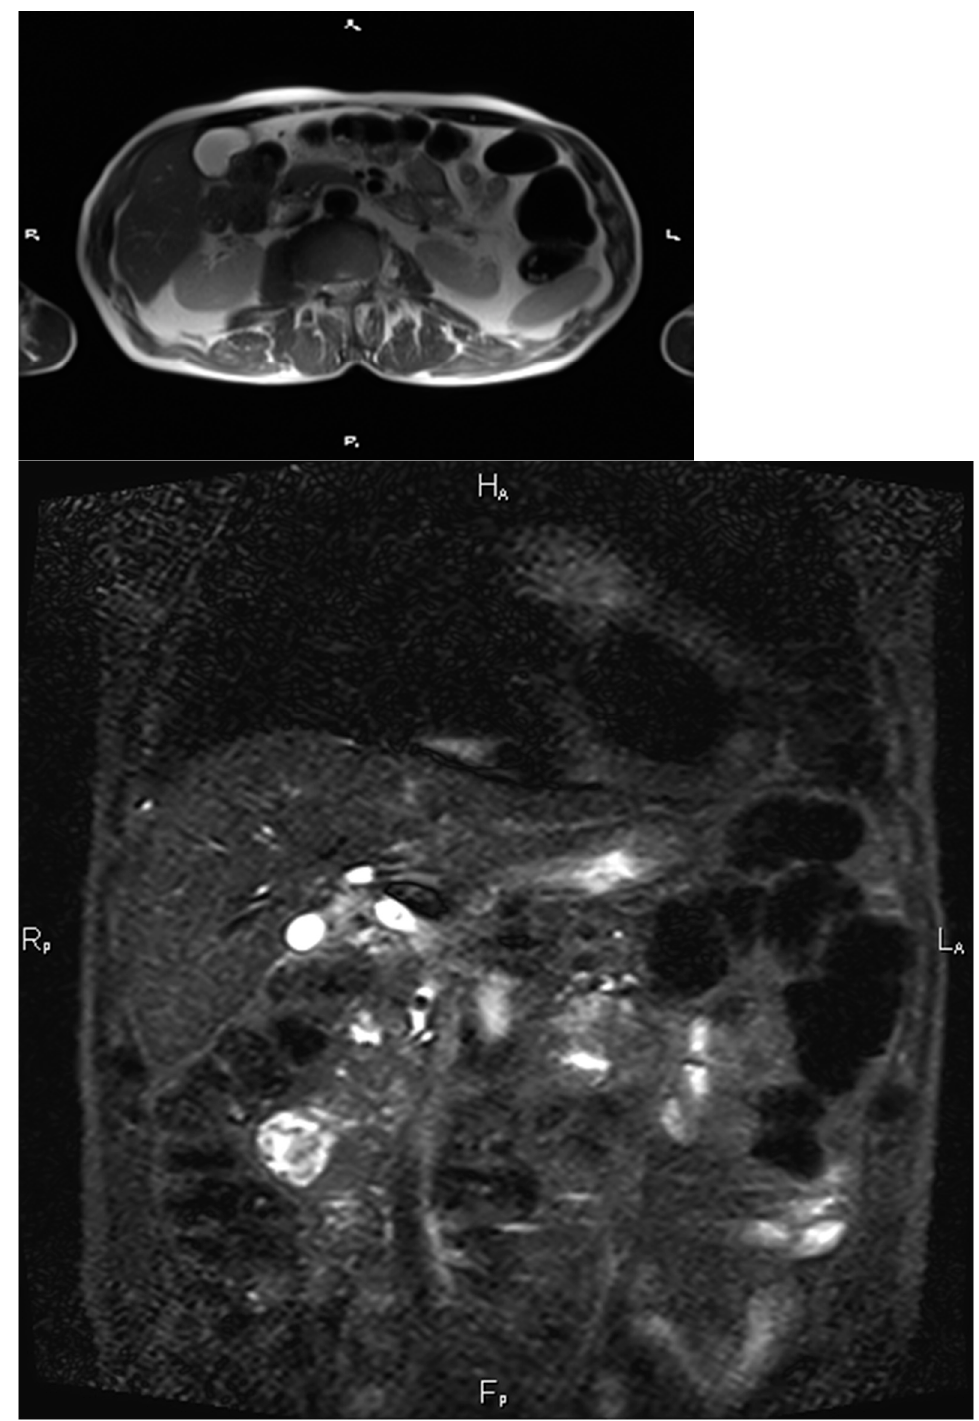
Figure 3. Magnetic resonance imaging of choledocholithiasis. Case courtesy of Mohammadtaghi Niknejad. From https://radiopaedia.org/?lang=us (accessed on 21 February 2023). Some studies reported that the disease severity plays a useful role in predicting vital prognosis [49], as well as the duration of hospitalization and the rate of conversion to laparotomy, the latter being significantly higher in more severe cases [50,51]. In other studies, however, severe cholecystitis may be drained; although, percutaneous cholecystostomy is not always feasible, and open cholecystectomy may be necessary [52,53].